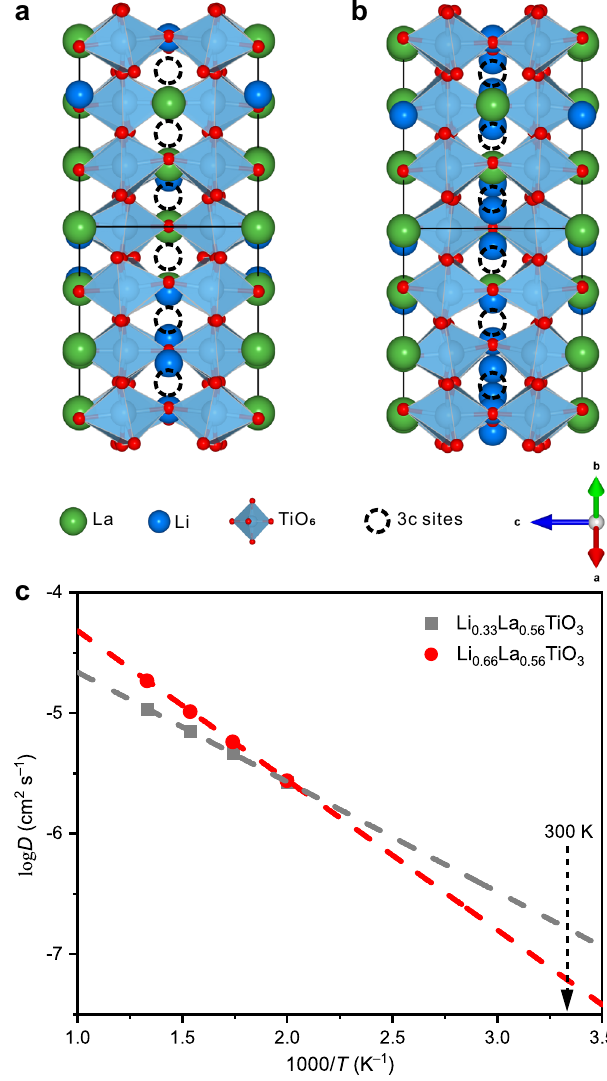
Fig. 4 | AIMD simulations of the Li-ion transport. a , b Optimized models of Li 0.33 La 0.56 TiO 3 ( a ) and Li 0.66 La 0.56 TiO 3 ( b ) viewed along <110> p . The 3c interstitial sites are marked by dashed circles. c Arrhenius plots of the calculated diffusion coef fi cients D for Li 0.33 La 0.56 TiO 3 and Li 0.66 La 0.56 TiO 3 . The diffusion coef fi cients at 500,575,650, and 750K wereobtained directlyfrom AIMD simulations, and those at 300K were inferred by fi tting the high-temperature data using the Arrhenius